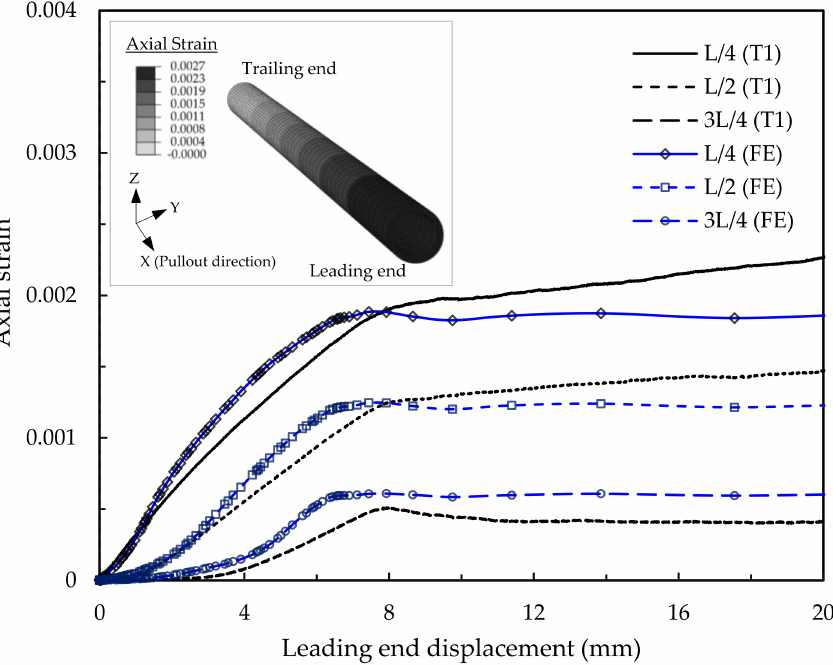
Figure 8. Comparison of axial strains at different locations of the pipes in test T1 (the inserted figure shows pipe axial strain from FE calculation at peak pullout